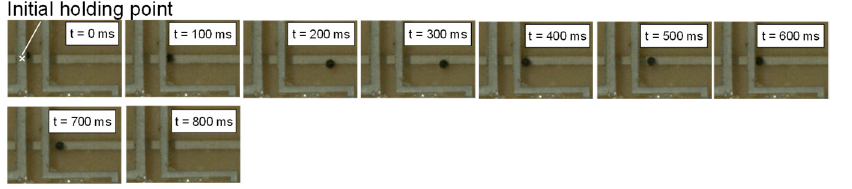
Figure 12. Transfer from an initial holding point to the adjacent cross point (the upper electrode of the initial point is grounded).